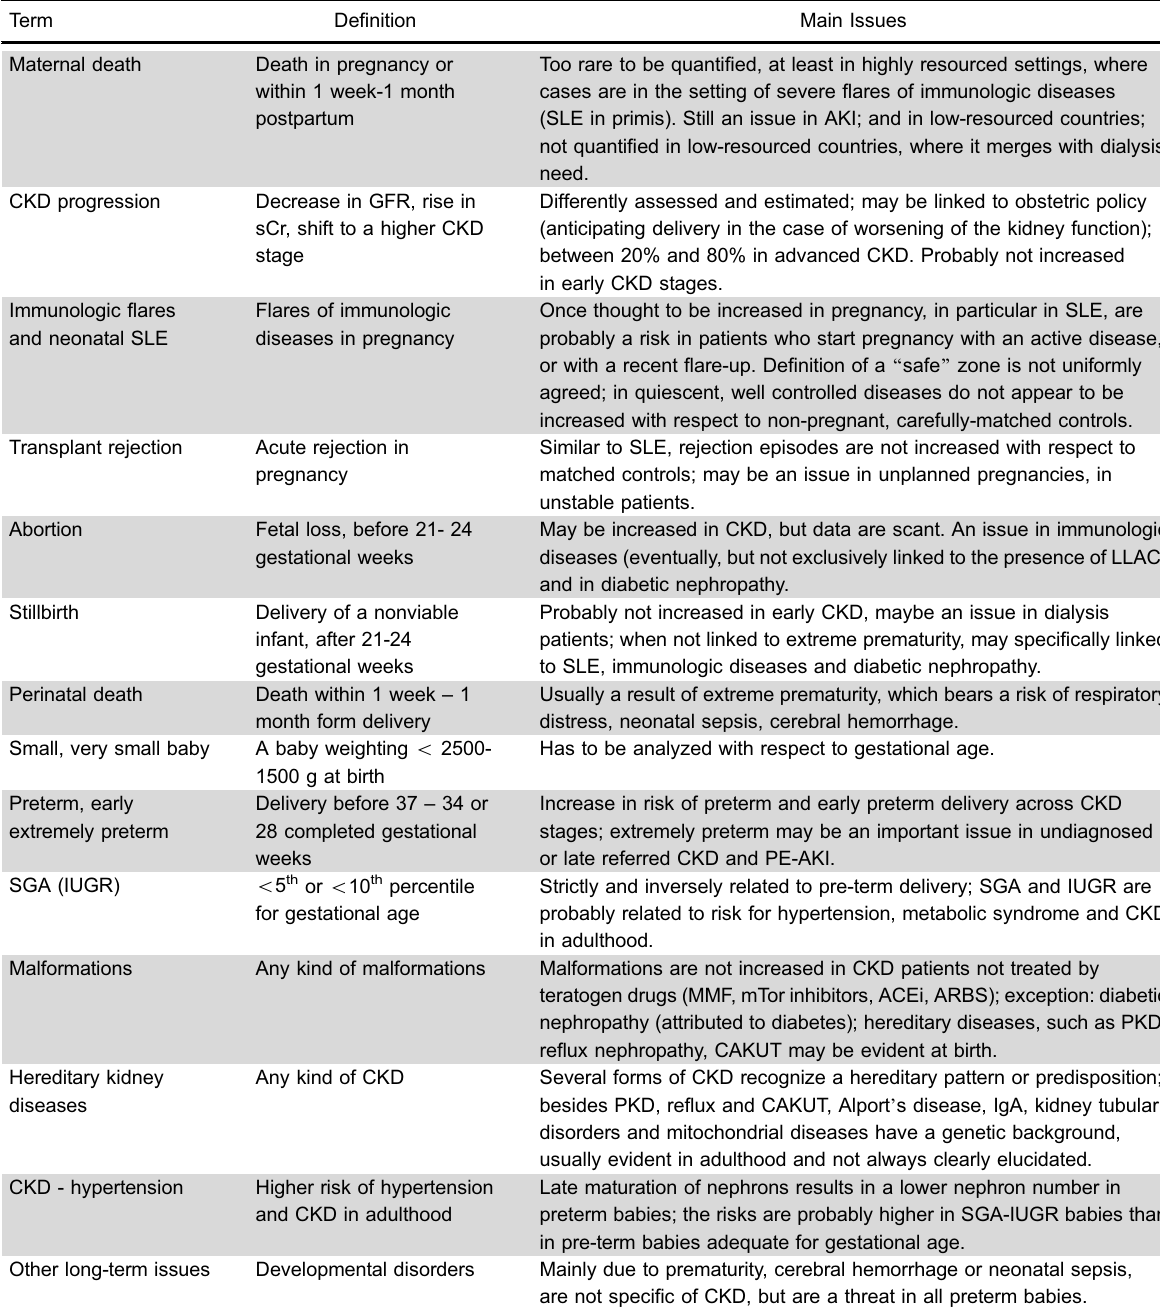
Table 1. Adverse pregnancy outcomes in patients with chronic kidney disease and in their